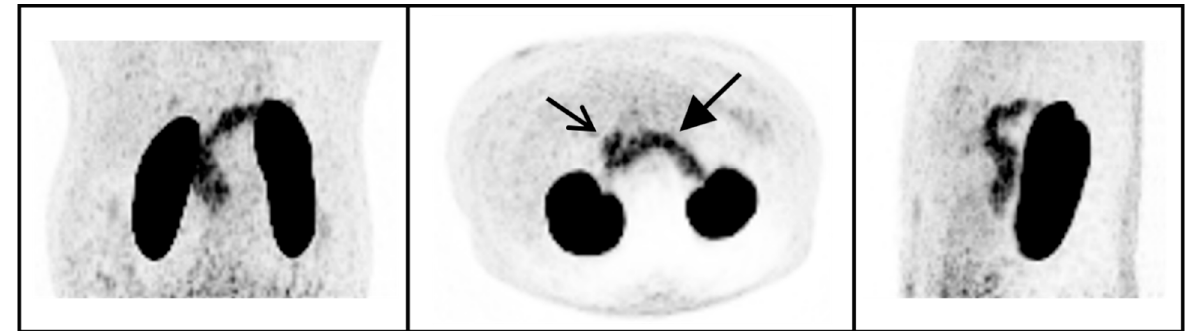
Figure 2. 68 Ga-NODAGA-exendin-4 PET maximum intensity projections of the abdomen of one subject in a coronal, axial, and sagittal view (left, middle, and right panel, respectively). Uptake in the pancreas (closed arrow), duodenum (open arrow) and kidneys can be observed.